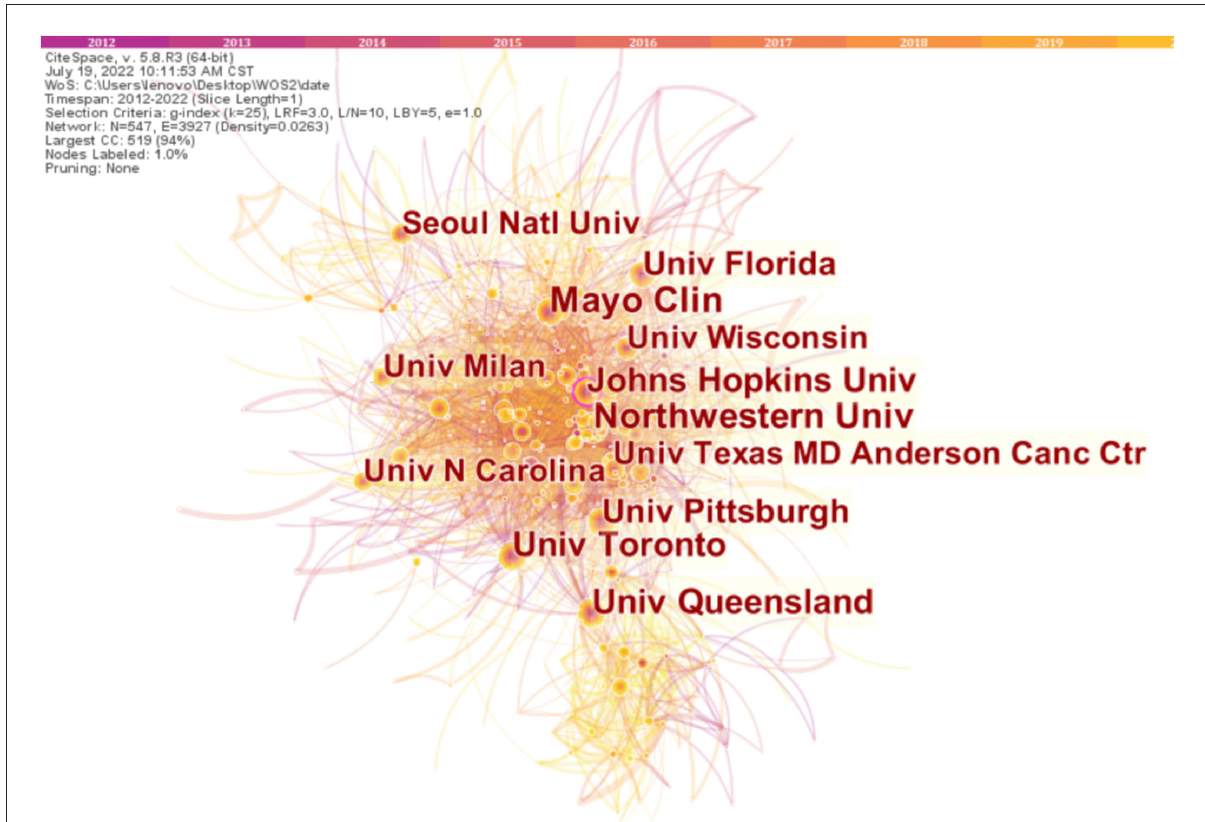
FIGURE5 Map of authors distribution and cooperative relations on dysphagia from 2012 to 2022. The larger the circle, the more articles are published in that institution. The shorter the distance between the two circles, the more the cooperation between the institutions.